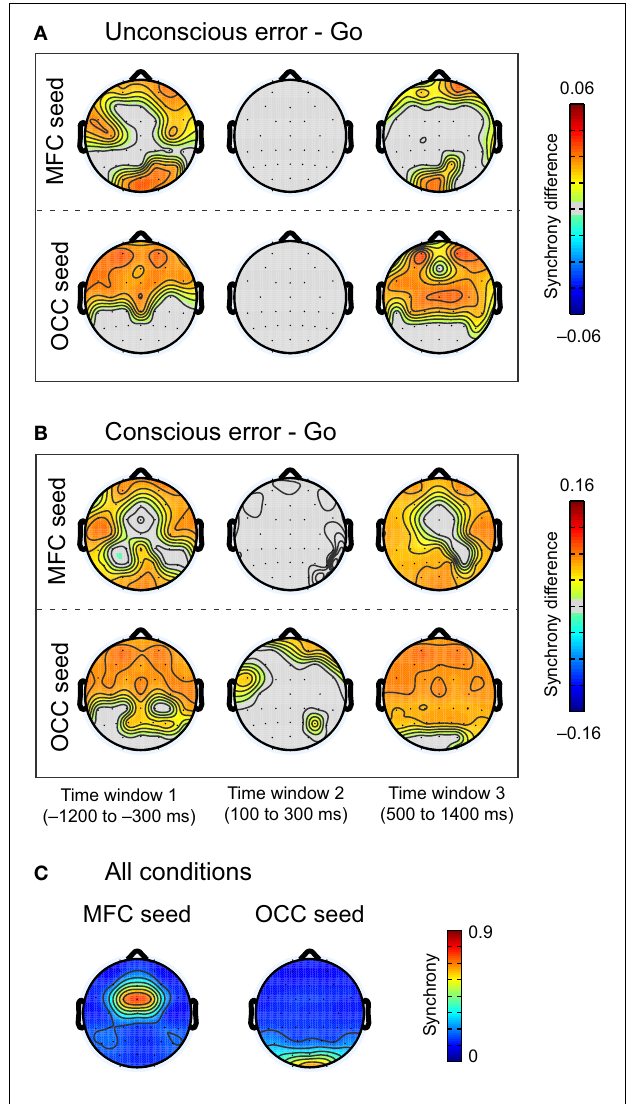
FIGURE 4 | Topographical analyses of oscillatory phase synchrony reveal spatial distribution of frontal-occipital connectivity following unconscious and conscious errors. In these analyses, phase synchrony between the MFC seed and every other electrode (top row of A and B ), and between the OCC seed and every other electrode (bottom row of A and B ) was calculated; differences between trials following unconscious errors and Go trials (A) and between trials following conscious errors and Go trials (B) are plotted. Electrodes with differences not statistically signifi cant at p < 2.22 × 10 − 5 had their values set to 0 (gray color). It can be seen that the MFC seed was signifi cantly more strongly synchronized with occipital regions, and that the OCC seed was signifi cantly more strongly synchronized with frontal regions, following unconscious and conscious errors. (C) Synchrony with MFC and OCC seeds when averaging across all time windows and conditions. These plots show that there is minimal contribution of volume conduction due to current-source-density